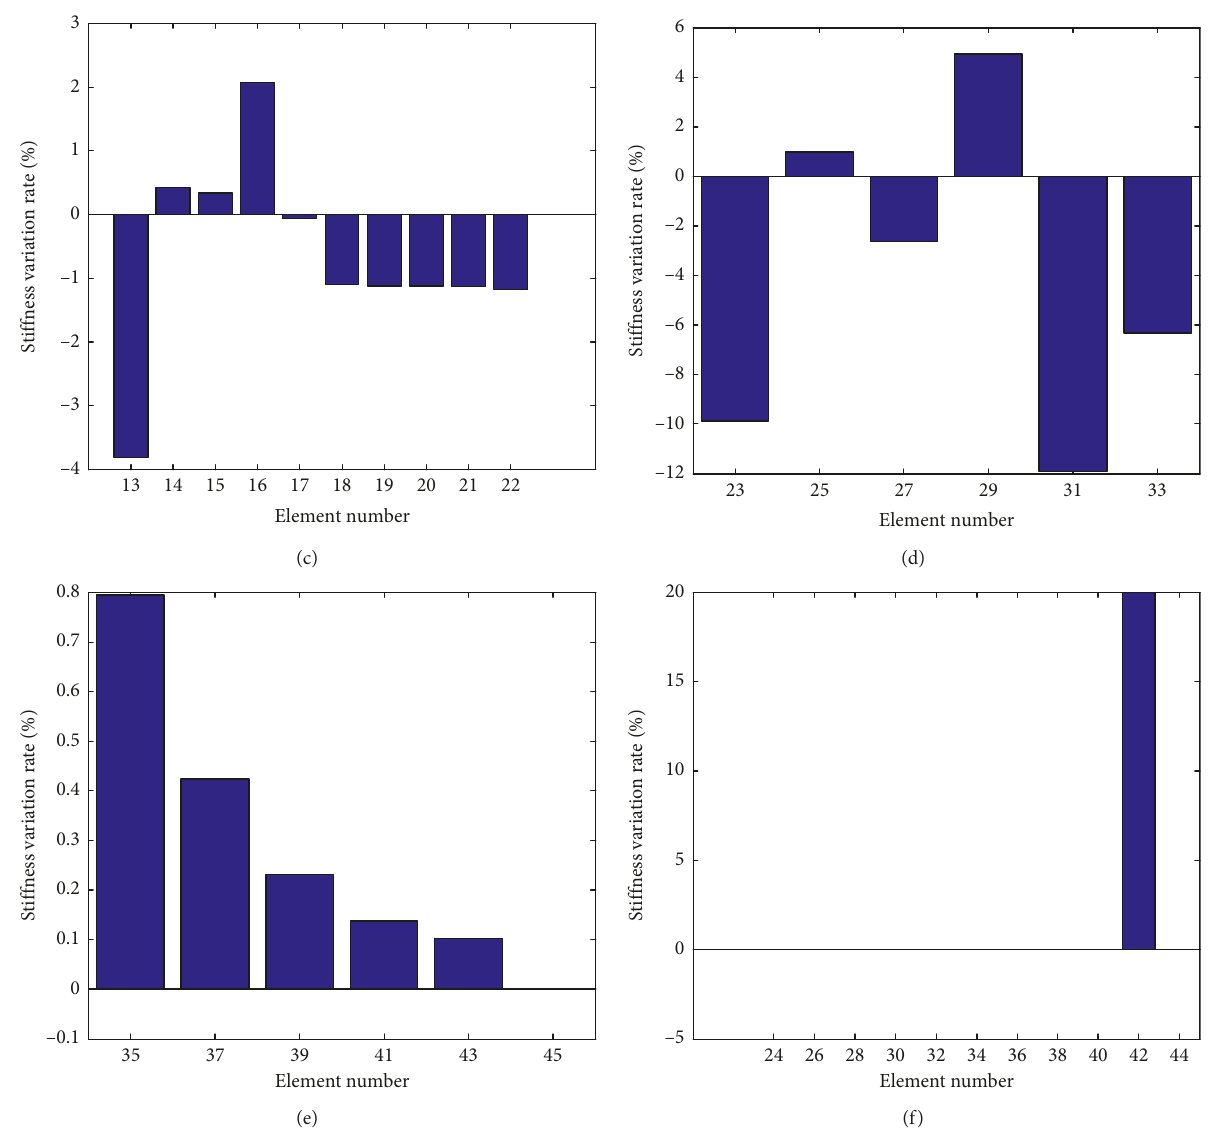
Figure 9: Damage detection using the expanded noise-free measurement data: (a) displacement variations; (b) stiffness variation rate at lower chords; (c) stiffness variation rate at upper chords; (d) stiffness variation rate at “/”-type diagonal elements; (e) stiffness variation rate at “\”-type diagonal elements; (f) stiffness variation rate at vertical elements. In (a), the solid line indicates the horizontal displacement and the dashed line indicates the vertical